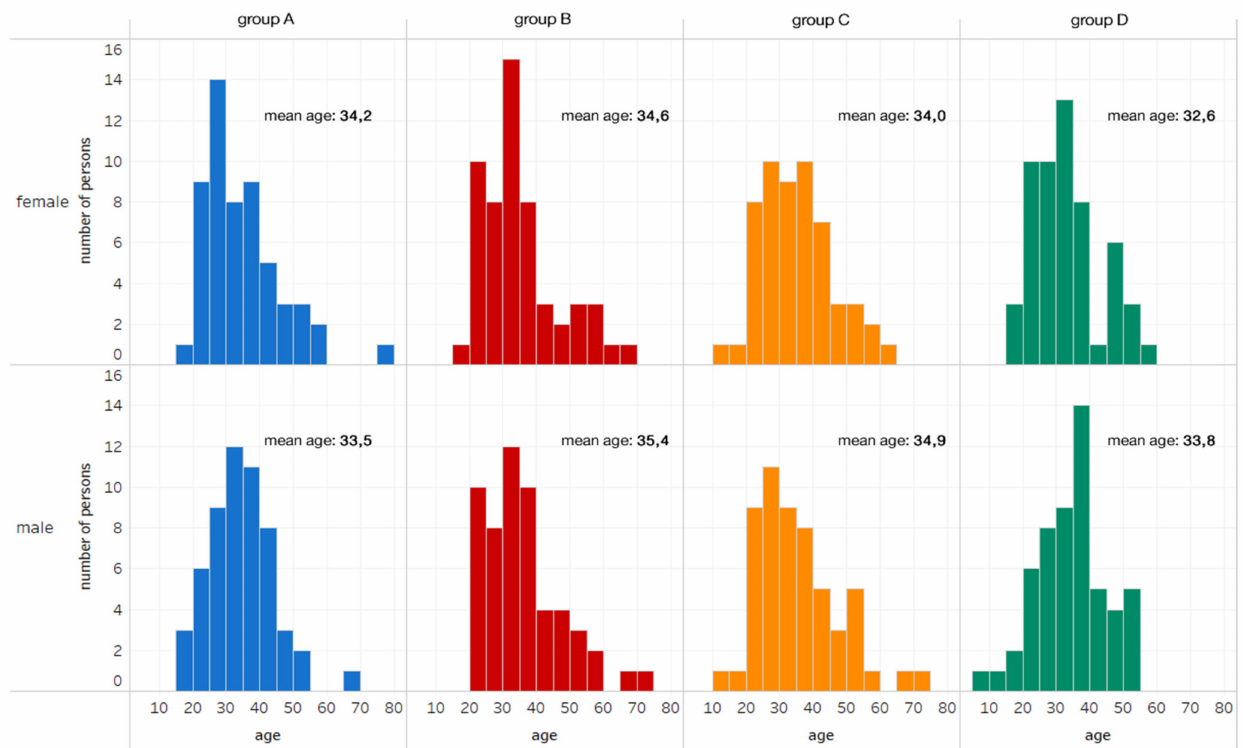
Figure 5. Age distribution by sex and group.